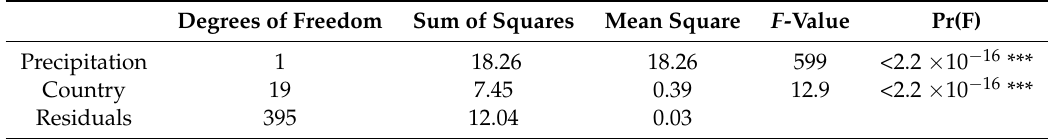
Table A3. *** represent estimates that have p -values smaller than 0.001.